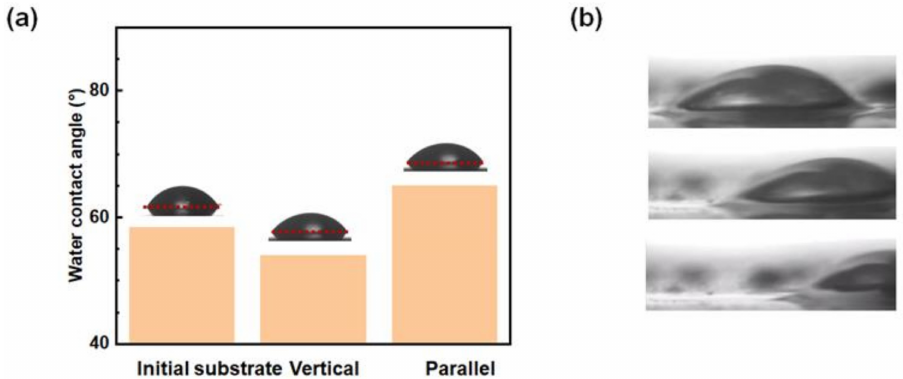
Figure 7. ( a ) The contact angle of the initial sample and the laser processed sample. ( b ) The surface droplet sliding.